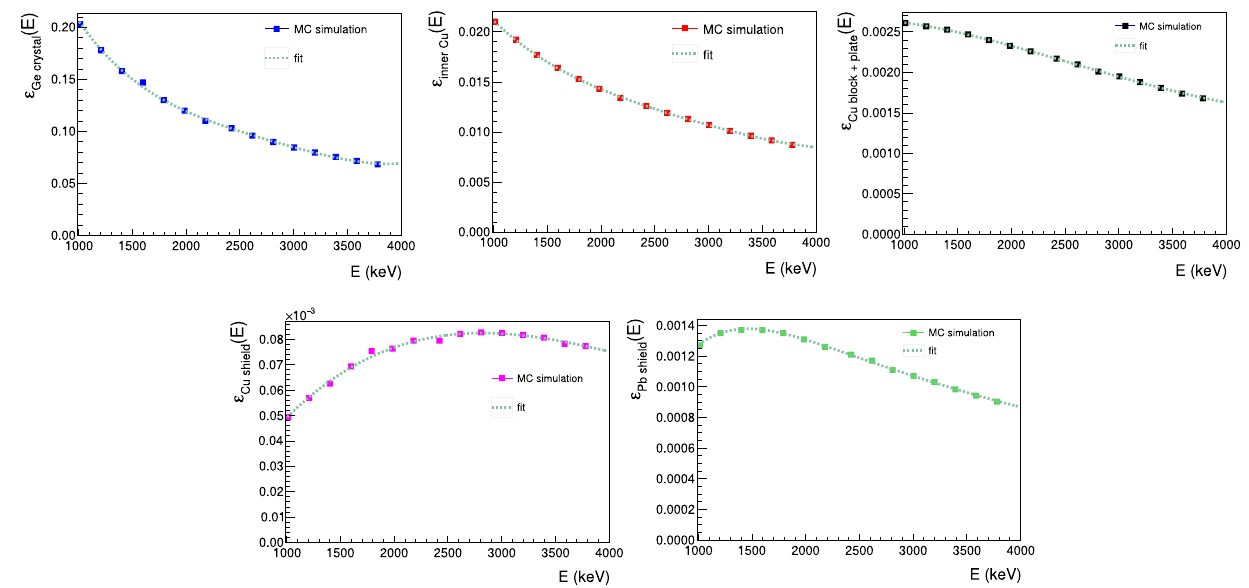
Fig. 2 The results of the fits of the efficiency spectra, for those compo- nents of the setup which are found to give significant contribution: Ge crystal (top left panel), inner Cu (top middle panel), Cu block + plate